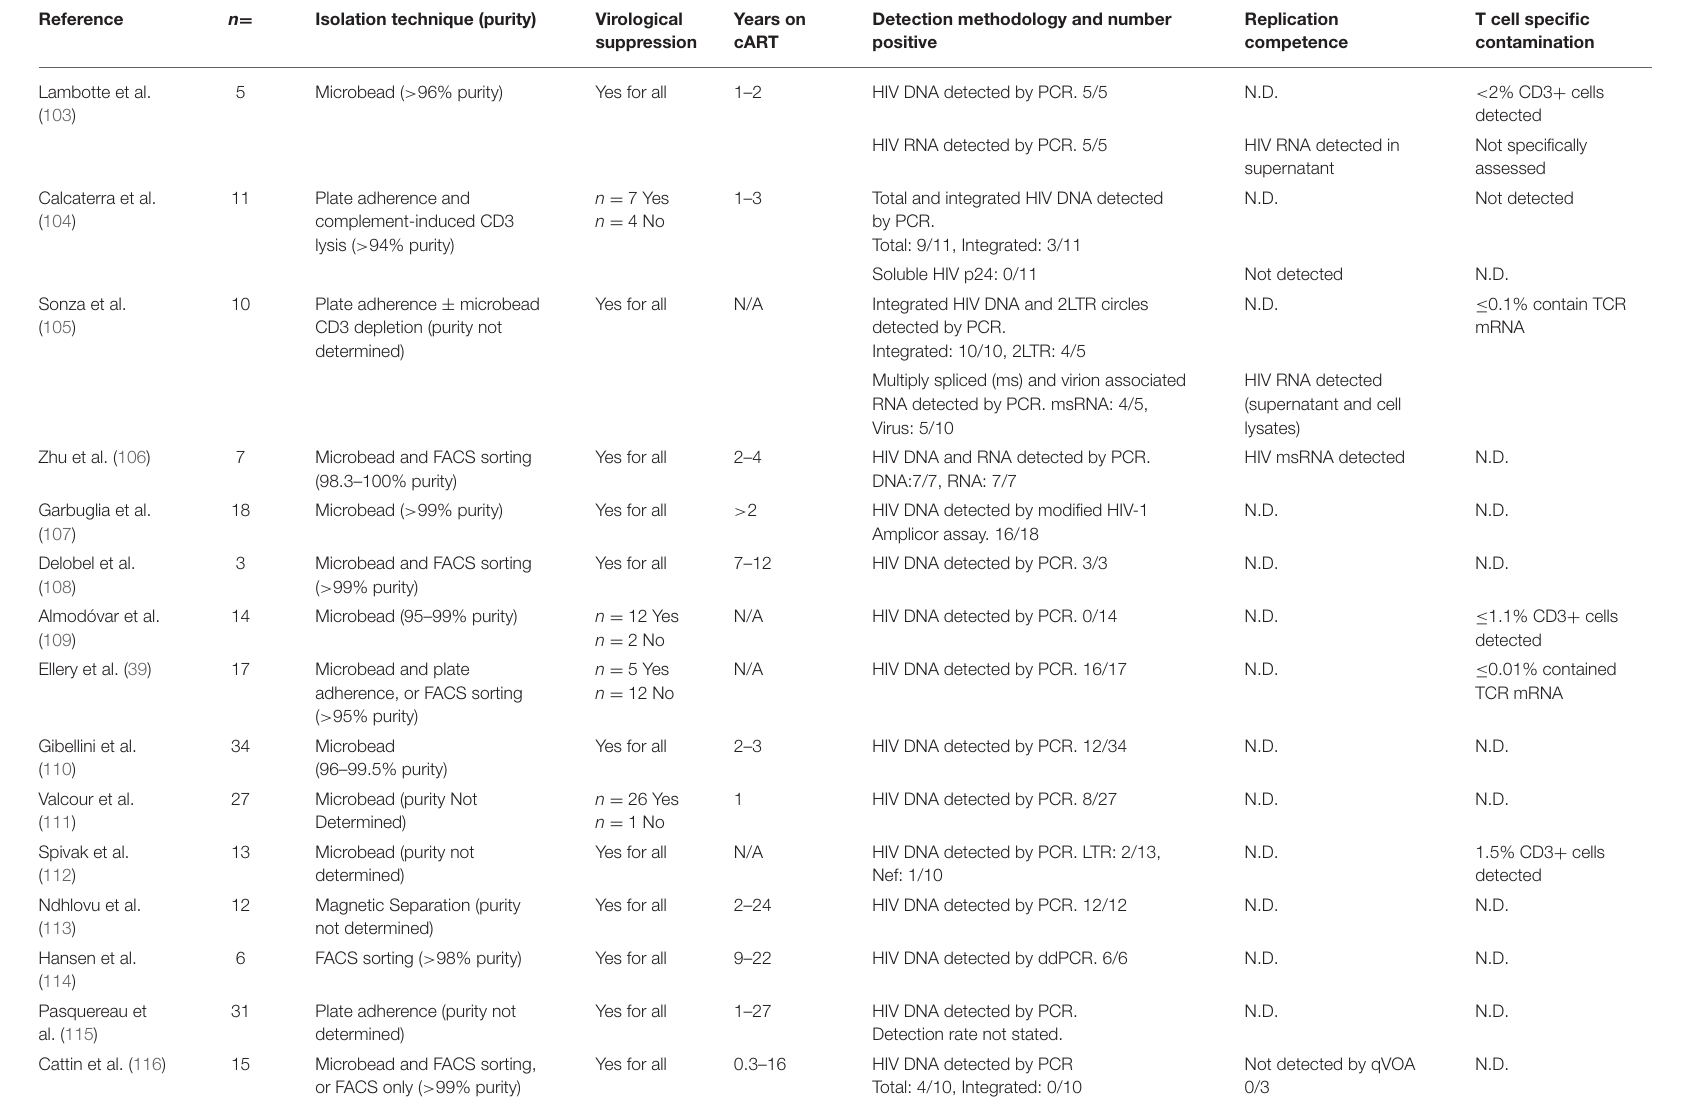
TABLE 1 | Evidence for the infection and persistence of HIV within